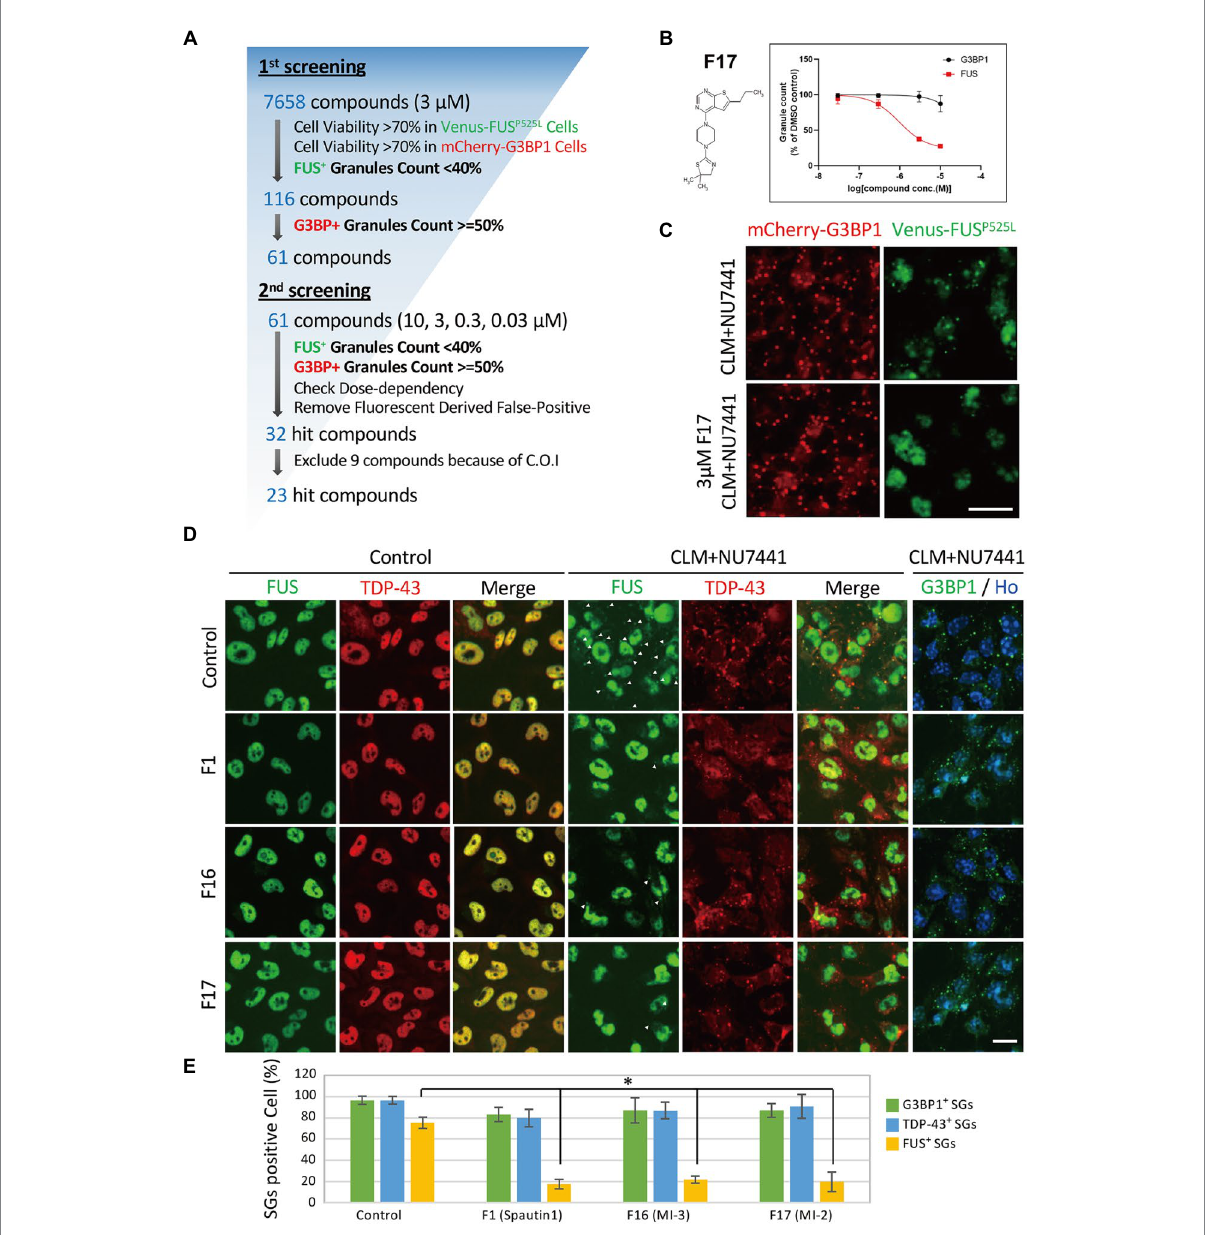
FIGURE 5 Compound screening for inhibition of FUS-containing SG formation. (A) Compound screening flowchart. See the methods section for details. (B) Dose-response curve of Compound F17 as one of the 23 hit compounds. T-3811487 (3 μ M), a representative hit compound, did not inhibit the formation of G3BP1-positive SGs (black line) but inhibited the localization of FUS P525L (red line) to SGs. The vertical axis shows the inhibition rate (%) of granule formation. (C) Fluorescence image of cells treated with 3 μ M F17. The scale bars represent 20 μ m. (D) Validation of the effects of the hit compounds on endogenous FUS protein localization. U251MG (KO) cells were pretreated with 3 μ M F1, F16, and F17 and were then treated with 100 nM CLM and 10 μ M NU7441 or with DMSO (control) for 6 h. The images show immunocytochemistry for G3BP1-positive puncta G3BP1 (green) and Hoechst (blue), control for SGs, TDP-43 (red), and FUS (green). The arrowheads indicate FUS-positive SGs. The scale bars represent 20 μ m. (E) Relative population of the cells containing cytosolic stress granules were calculated to total cells. Values represent mean ± SD. Asterisk indicates significant change relative to FUS-SGs containing cells of DMSO control with CLM + NU7441 treatment ( t -test p <